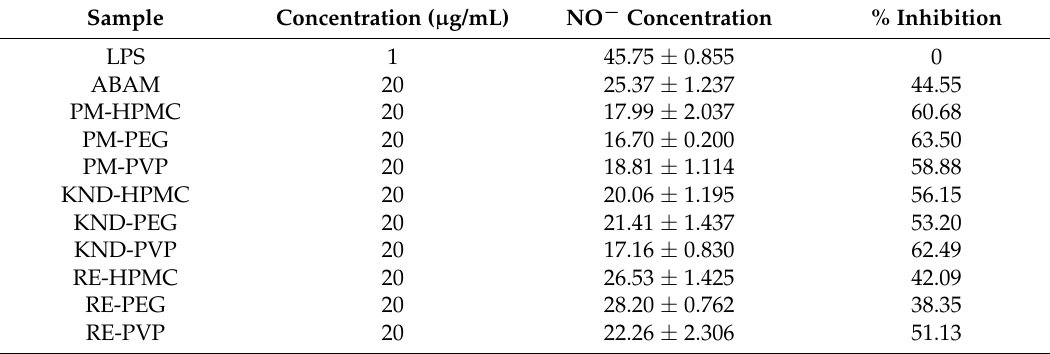
Figure 6. Effect of ABAM (alone and as a solid dispersion with hydrophilic polymers) on the production NO· in J774 macrophages stimulated by LPS. ( A ) NO· production in the presence of ABAM alone and as PMs compared to that of the LPS group ( B ) NO· production in the presence of ABAM alone and as a SD prepared by KND compared to that of the LPS group ( C ) NO· production in the presence of ABAM alone and as SD prepared by RE compared to that of the LPS group. Values expressed as mean ± SD (eror bar) with n = 5. * p < 0.0001, when compared to LSP group; † p < 0.05 or †† p < 0.01 when compared to ABAM and its SDs. Statistical analysis performed by one-way ANOVA followed by Newman–Keuls test. Table 1. Inhibition of LPS-induced NO· production from J774 macrophages by ABAM alone and as